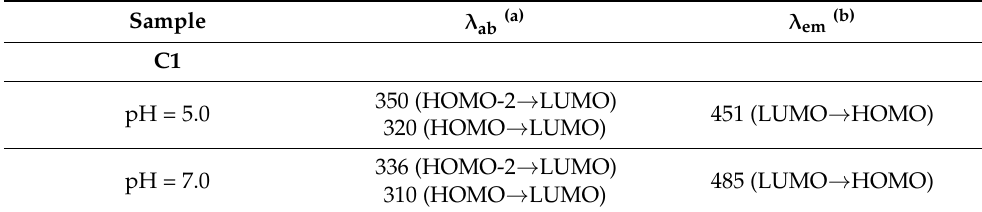
Table 4. Computed absorption and emission maxima of C1 in slightly acidic (5.0) and basic (7.5) solutions.